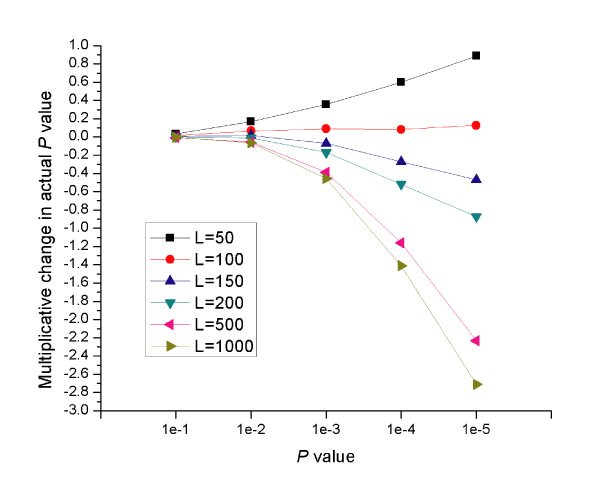
Multiplicative changes in p-values with genomic control in Affymetrix dataset.